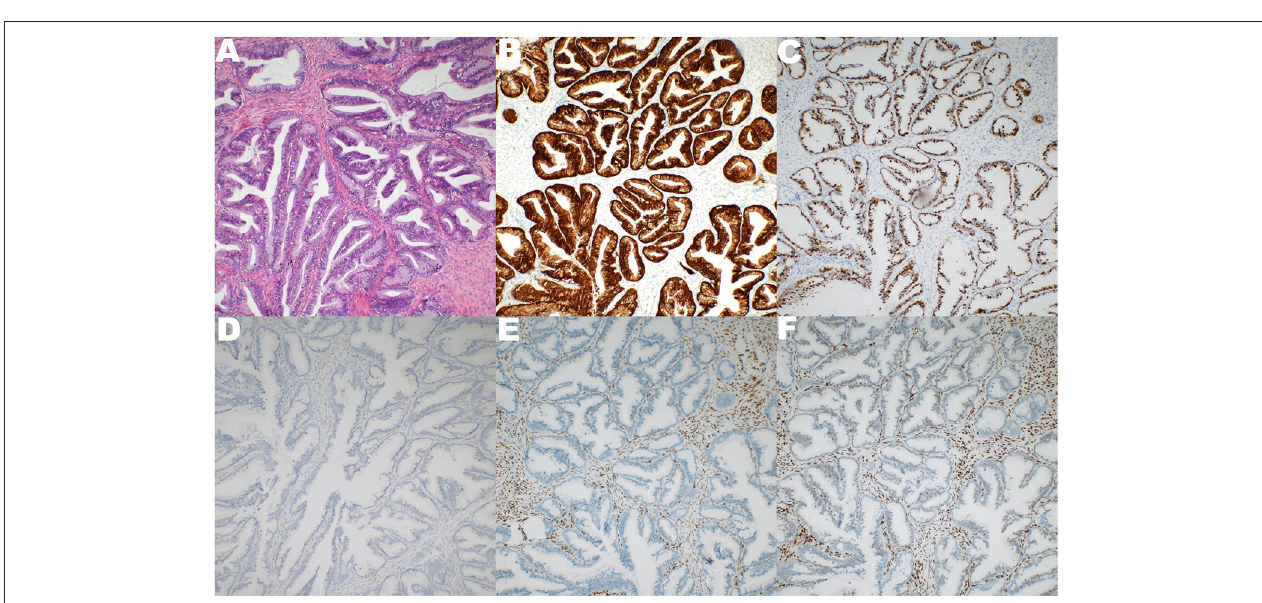
FIGURE 4 | The specimen representing broken cystic wall-like tissue, 5 × 4.5 × 2cm in size. Pathological diagnosis is HPV-associated adenocarcinoma (HPVA). (A) The components of carcinoma were lobular, tubular and villous in smooth muscle and fibrous tissue of cystic wall. (B) Immunohistochemical P16 positive. (C) Immunohistochemical Ki-67 50% positive. (D) Immunohistochemical WT-1 negative. (E) Immunohistochemical ER negative. (F) Immunohistochemical PR negative.